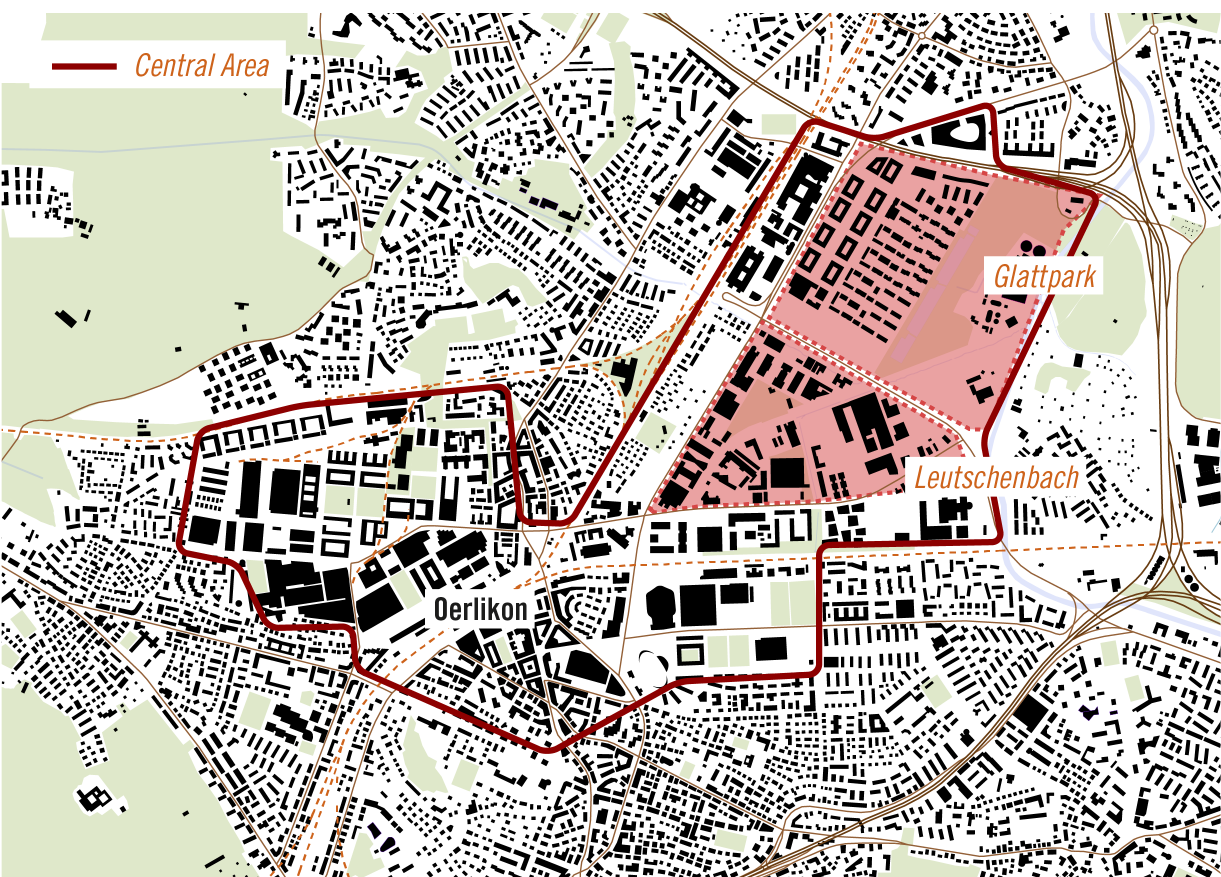
Figure 7. Definition of central areas in the Glatttal including the area of Glattpark in Opfikon. Source: author.